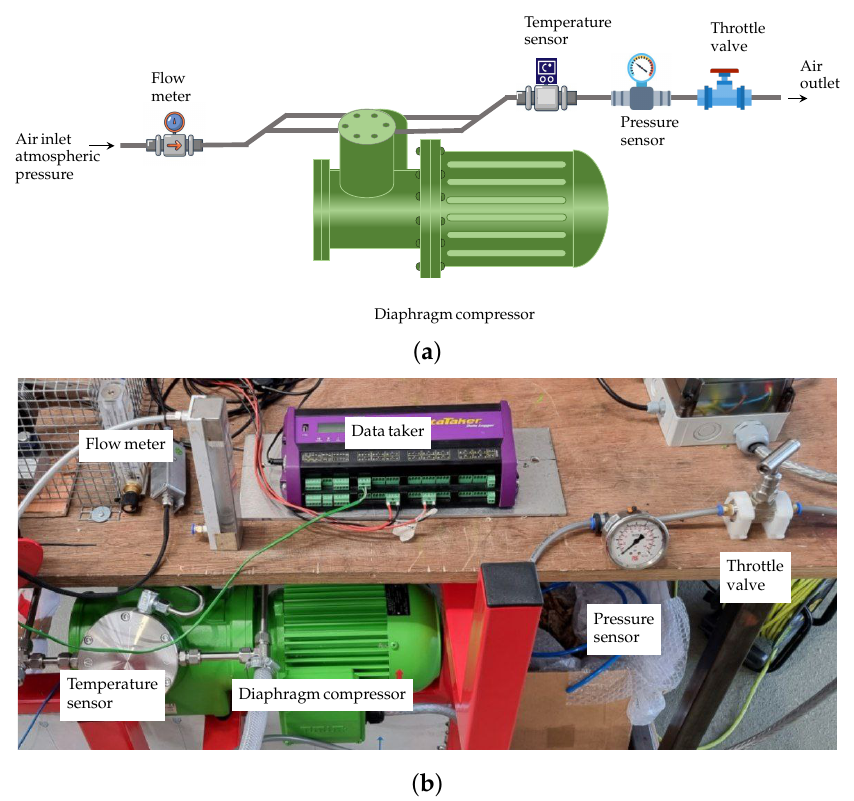
Figure 7. Experimental apparatus ( a ) schematic, and ( b ) the laboratory apparatus of the experimental model. The system has flow, temperature, and pressure sensors and the compression ration is adjustable in the system.